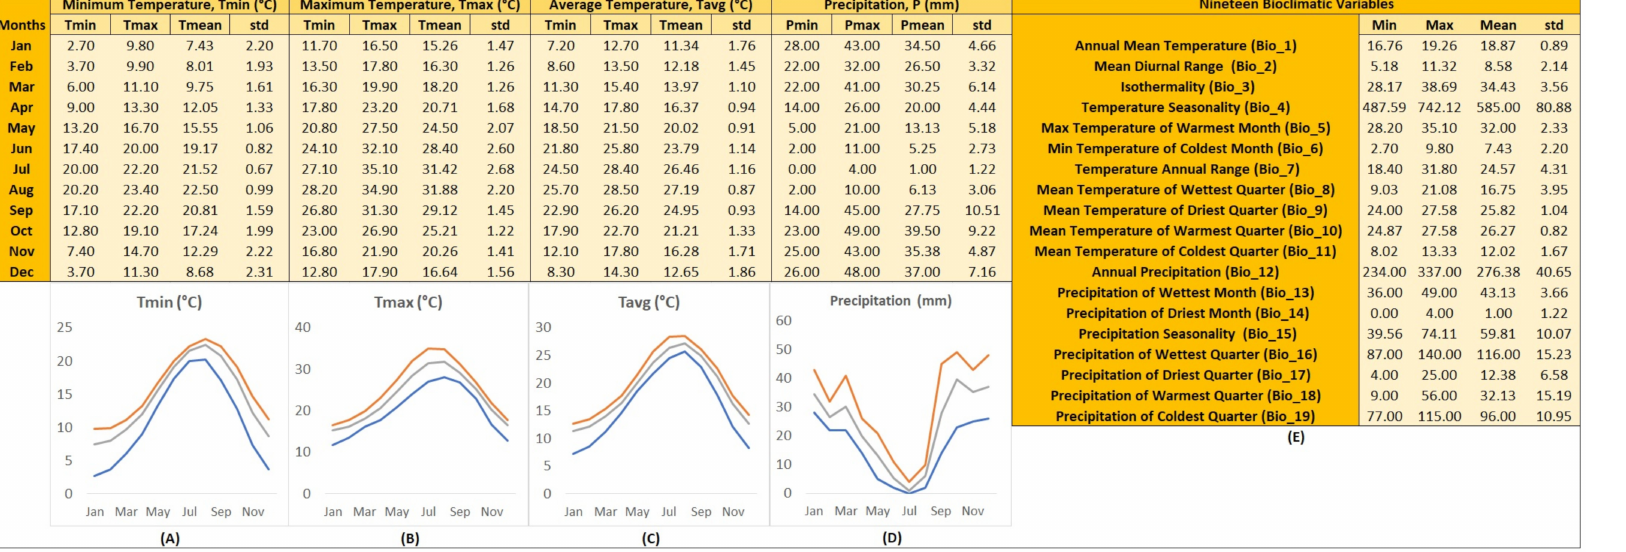
Figure 6. Ecological profile across the natural distribution range of Teucrium luteum subsp. gabesianum wild-growing populations in Tunisia linked in GIS with geodatabases (WorldClim version 2.1), providing values for: ( A ) minimum temperatures per month ( ◦ C), ( B ) maximum temperatures per month ( ◦ C), ( C ) average temperatures per month ( ◦ C), ( D ) precipitation per month (mm), and ( E ) calculated values for 19 bioclimatic variables. For ( A – E ) minimum, maximum, average, and standard deviation is shown based on data from 1970–2000. The colors of the plotted lines illustrate the minimum (blue), maximum (orange), and mean (grey) monthly values for temperature ( ◦ C) and precipitation